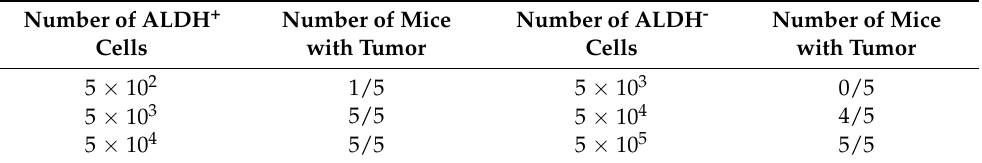
Table 1. Comparison of the ability of aldehyde dehydrogenase (ALDH)-positive and ALDH-negative. SW1736 to develop tumors in immunodeficient NCG (NOD/ShiLtJGpt- Prkdc em26 Il2rg em26 /Gpt) mice. Number of ALDH + Number of Mice Number of ALDH - Number of Cells with Tumor Cells